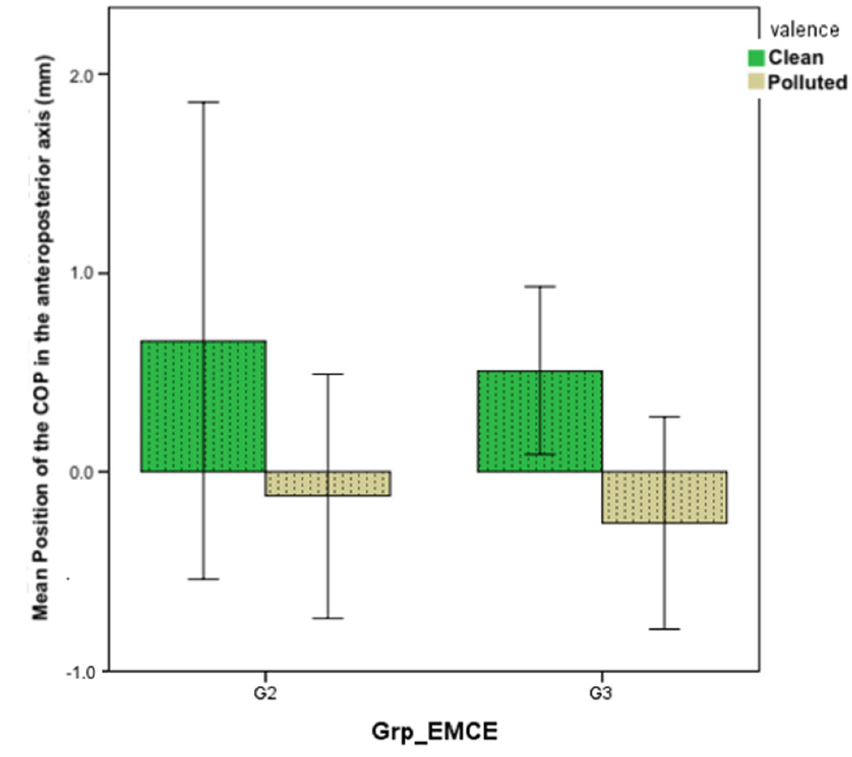
Figure 8. Shift of the COP in the AP axis according to the level of motivation towards ecological behaviors assessed by the WES scale.